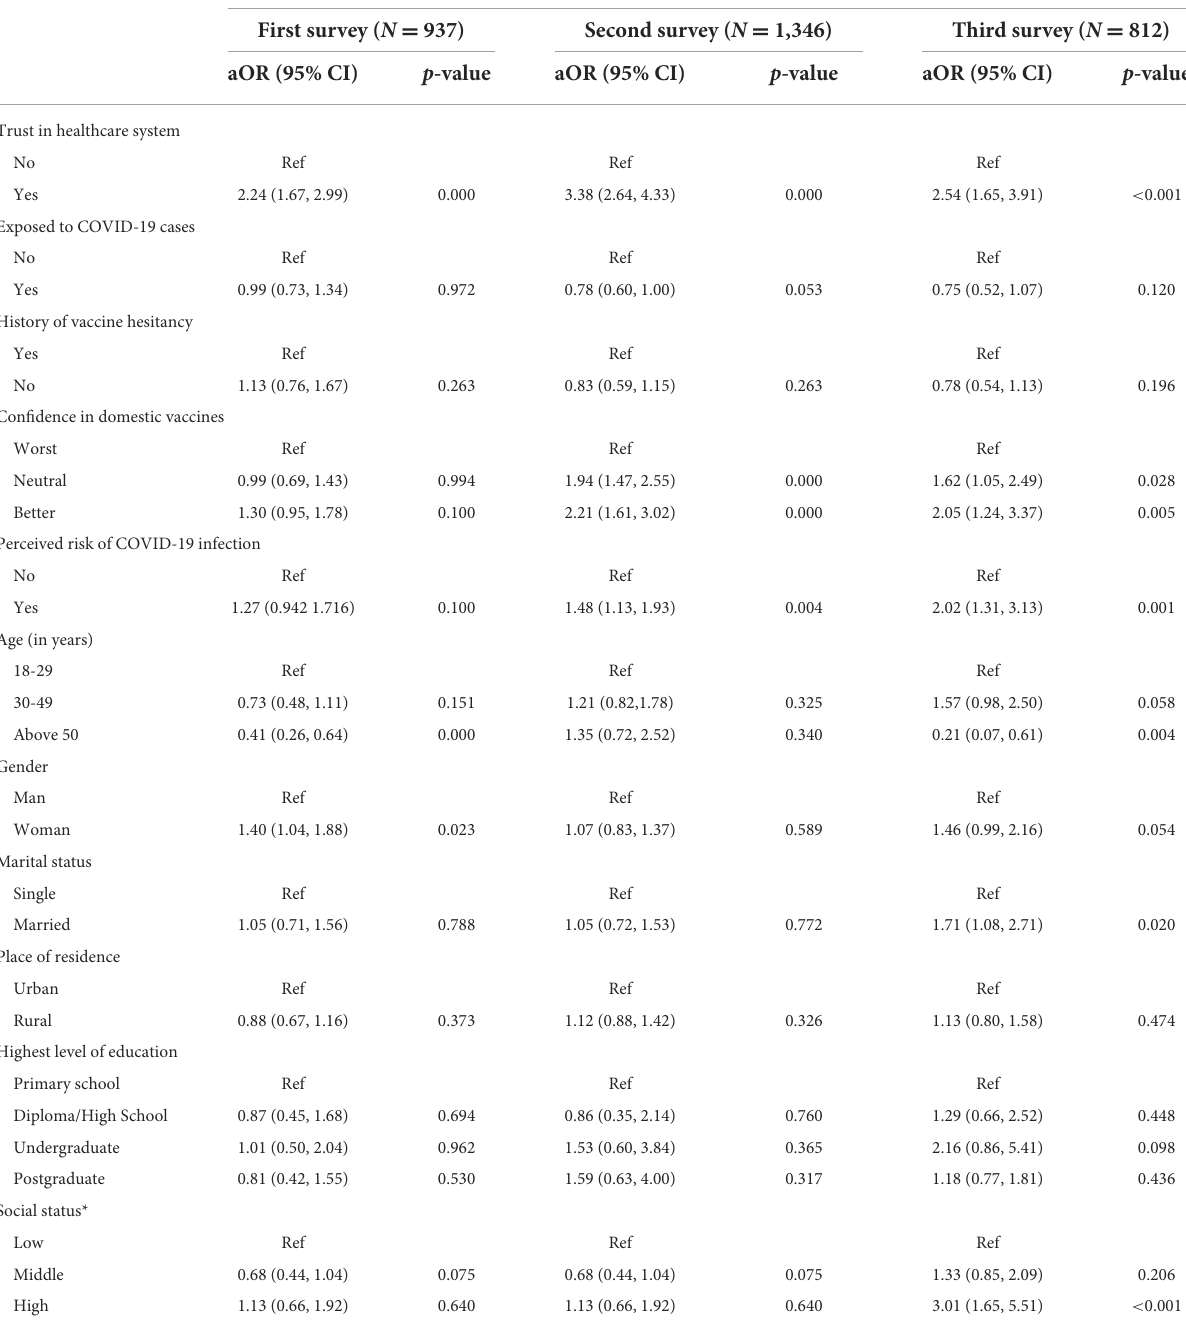
TABLE 3 Factors influencing COVID-19 vaccine uptake among HCWs: multivariable logistic regression analysis + . Willingness to receive COVID-19 vaccines First survey ( N =